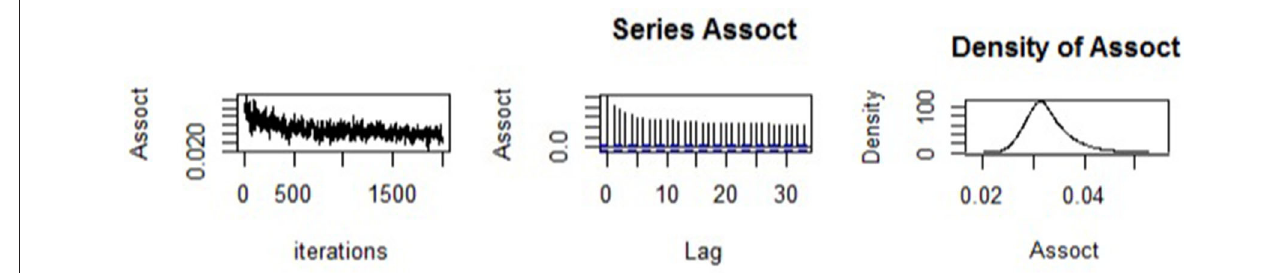
FIGURE 1 | Trace, density, and autocorrelation diagnostic plots for the association parameter.